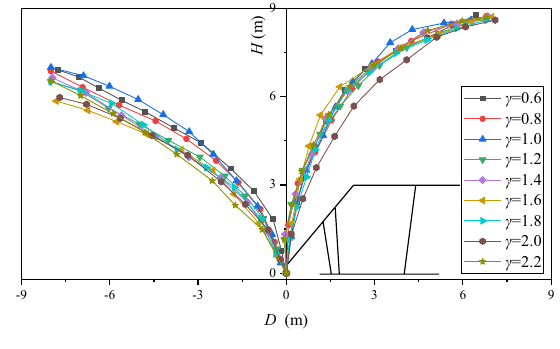
Fig. 15 Shapes of the initial top-coal boundary for different